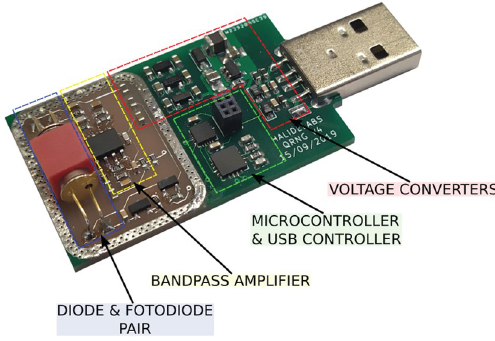
Figure 4. Prototype of miniaturized version of QRNG JUR02 designed at WUST (2020) – it passed all NIST/Dieharder tests without the bias reduction, at the speed of entropy creation 1 Mb/s (configured with conventional USB